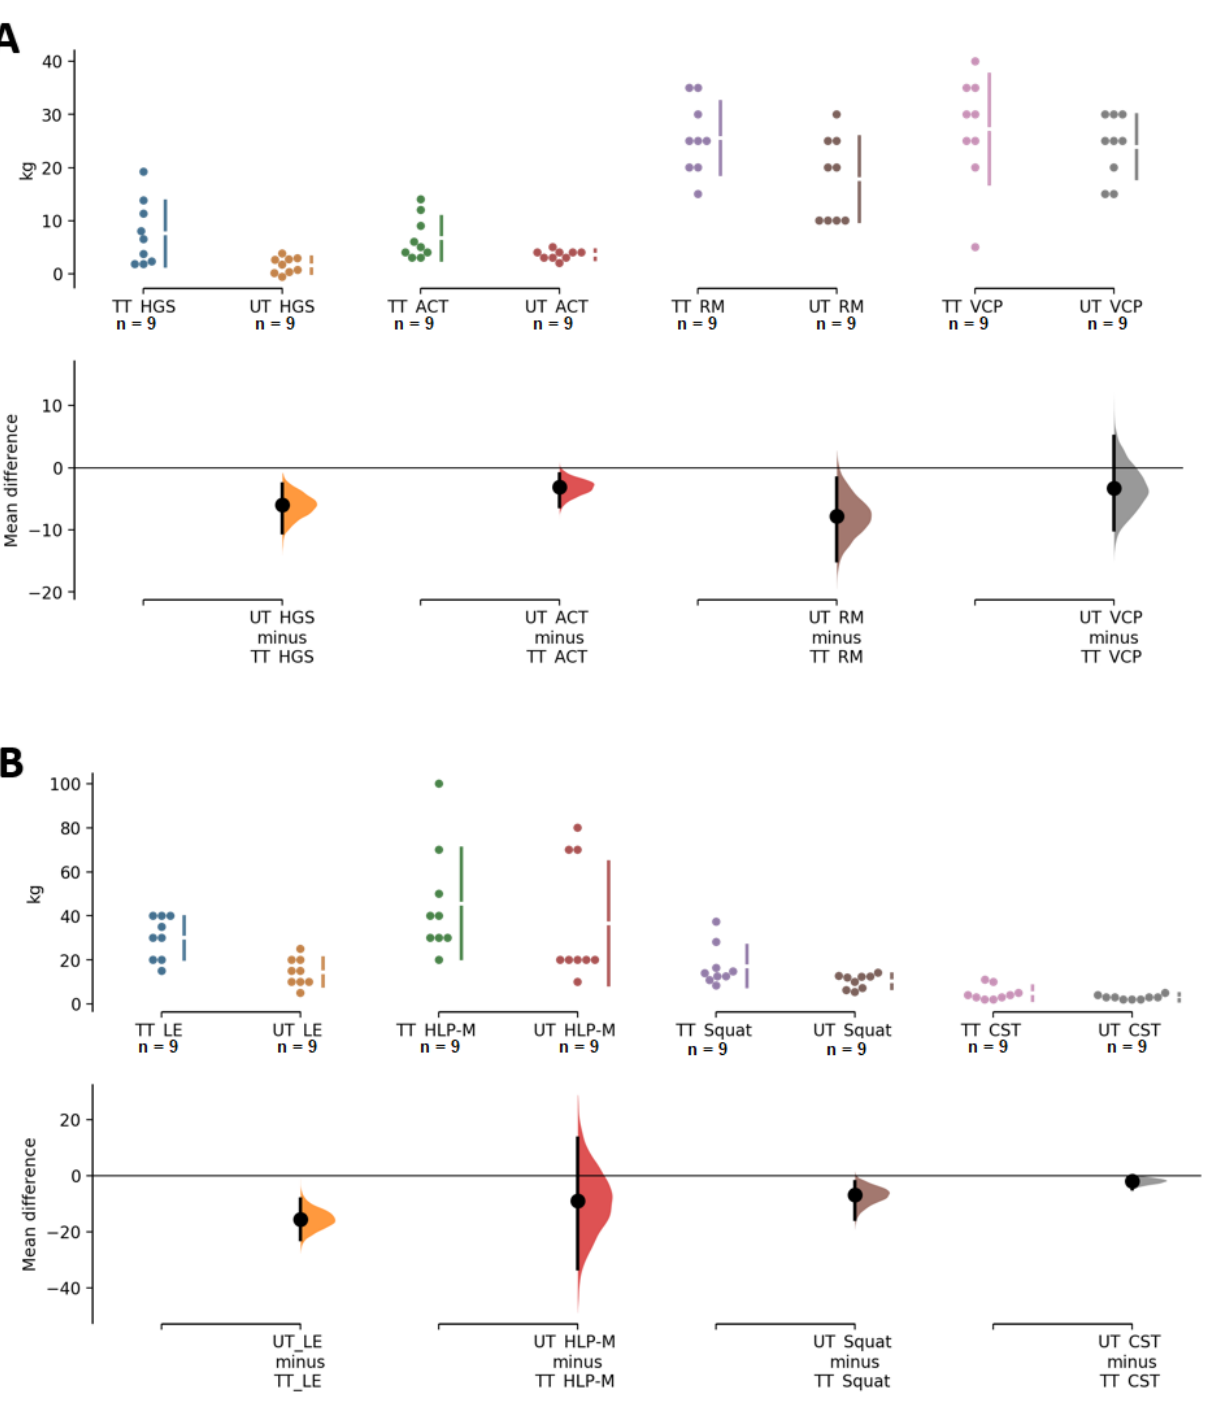
Figure 4. Paired Cumming estimation plots of upper- and lower-limb strength. ( A ) HGS, handgrip strength; ACT, 1 RM-Arm Curl test; RM, 1RM-Row machine, and VCP, 1 RM-vertical chest press ( B ) LE, 1 RM-Leg extension; HLP-M, 1 RM-Horizontal leg press-Monopodal; Squat; CST, and Chair stand test. TT, traditional training; UT, undulating training. Both groups are plotted on the left axes; the mean difference is plotted on a floating axis on the right as a bootstrap sampling distribution. The mean difference is depicted as a dot; the 95% confidence interval is indicated by the ends of the vertical error bar [28] .